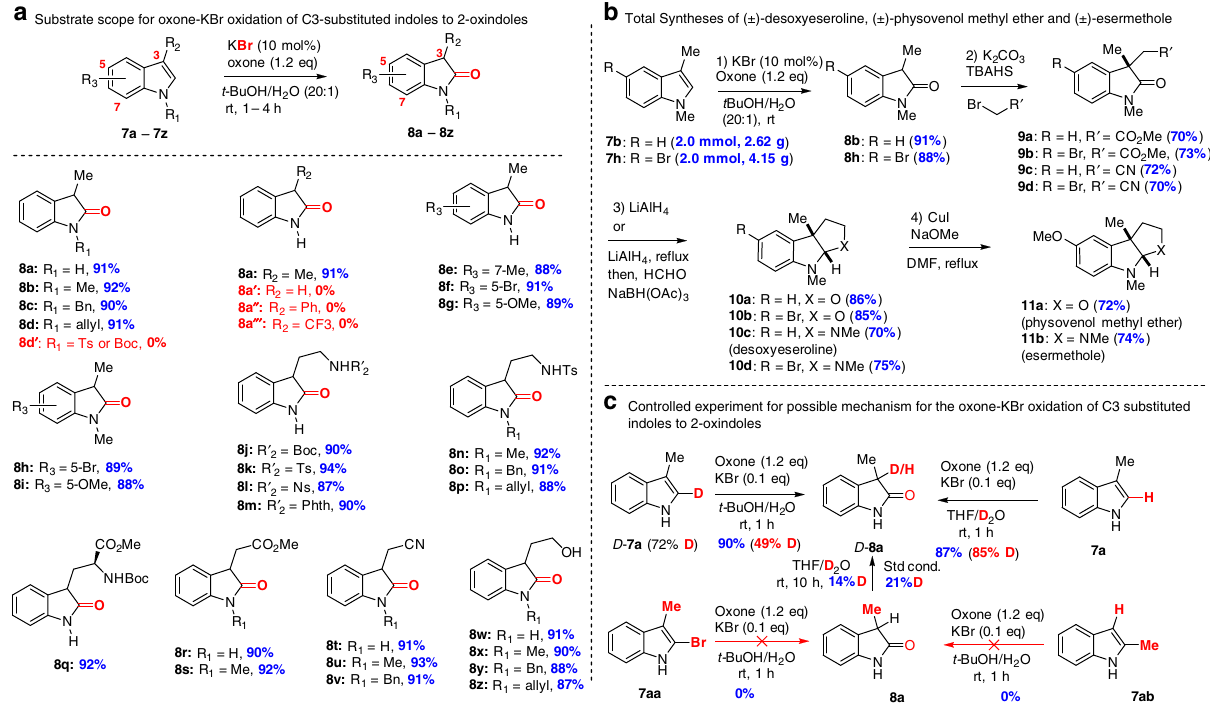
Fig. 5 Oxone-Halide oxidation of indoles to 2-oxindoles. a Substrate scope for oxone-KBr oxidation of C3-substituted indoles to 2-oxindoles. b Total syntheses of (±)-desoxyeseroline, (±)-physovenol methyl ether and (±)-esermethole. c Controlled experiments for possible mechanism for the oxone-KBr oxidation of C3 substituted indoles to 2-oxindoles. TBAHS Tetrabutylammonium hydrogen sulfate